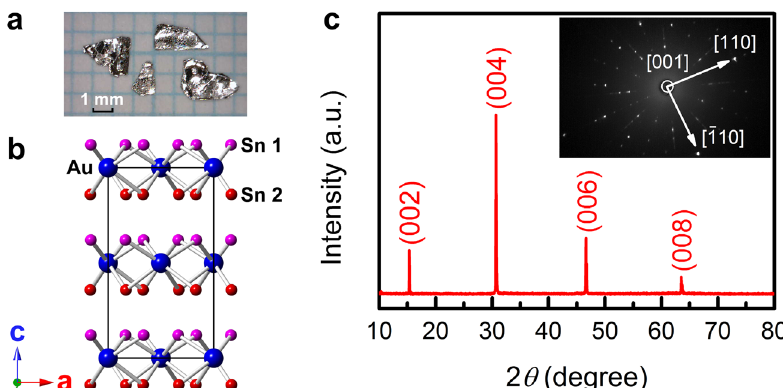
Fig. 1 Crystal structure of AuSn 4 . a A typical picture of the cleaved single crystals. b Schematic AuSn 4 crystal structure in real space. c X-ray θ − 2 θ diffraction spectrum for a single crystalline AuSn 4 specimen. Inset is a photograph of the Laue pattern from the [001] direction for AuSn 4 , and shows the directions of the crystal axes [110] and [ (cid:1) 110] as